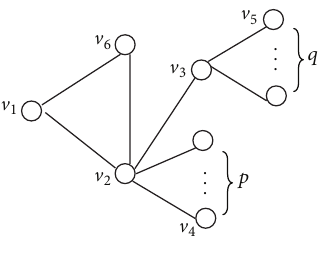
Figure 3: The graph 𝐺 2 (𝑝,𝑞)